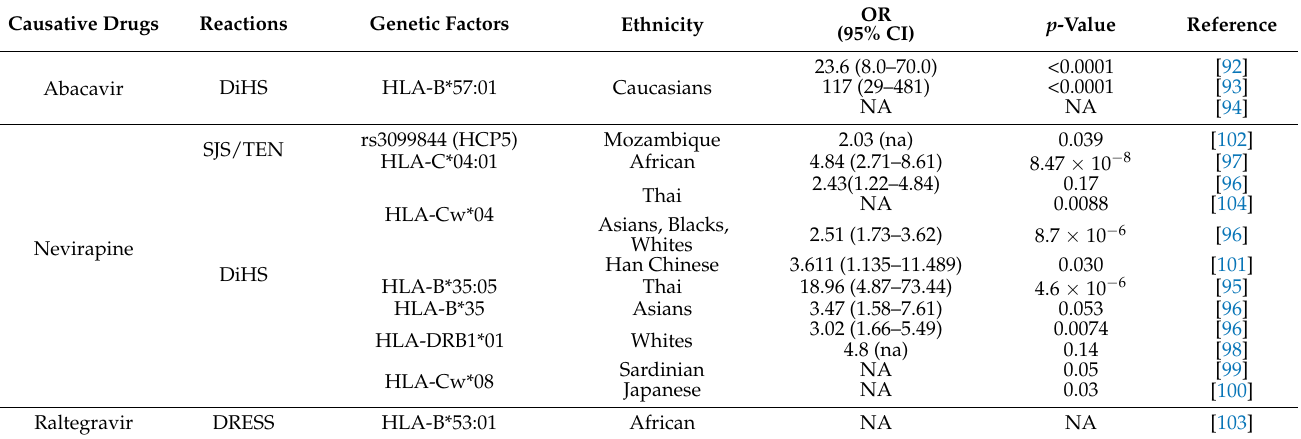
Table 5. Genetic variants associated with antiviral agents-induced hypersensitivity